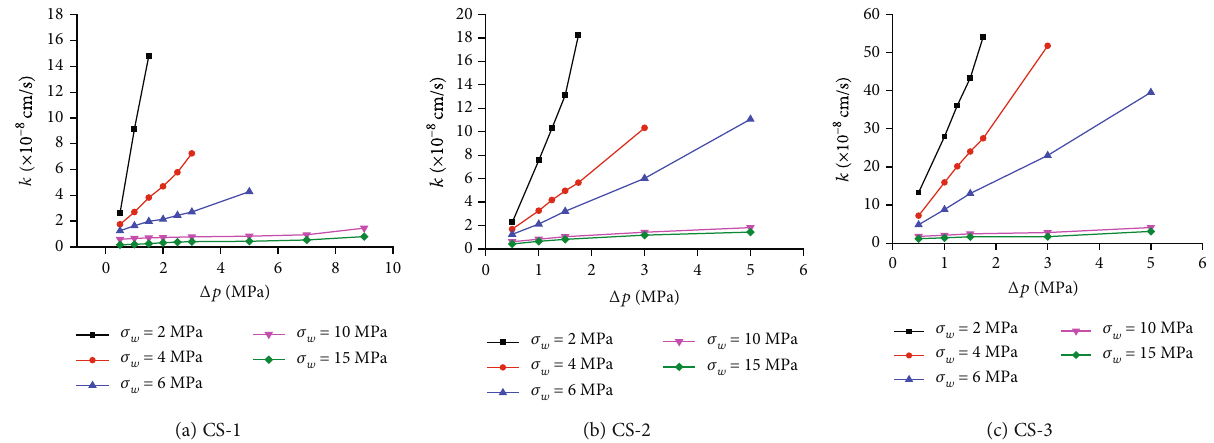
Figure 14: Relationship between permeability coe ffi cient and water pressure for CS.